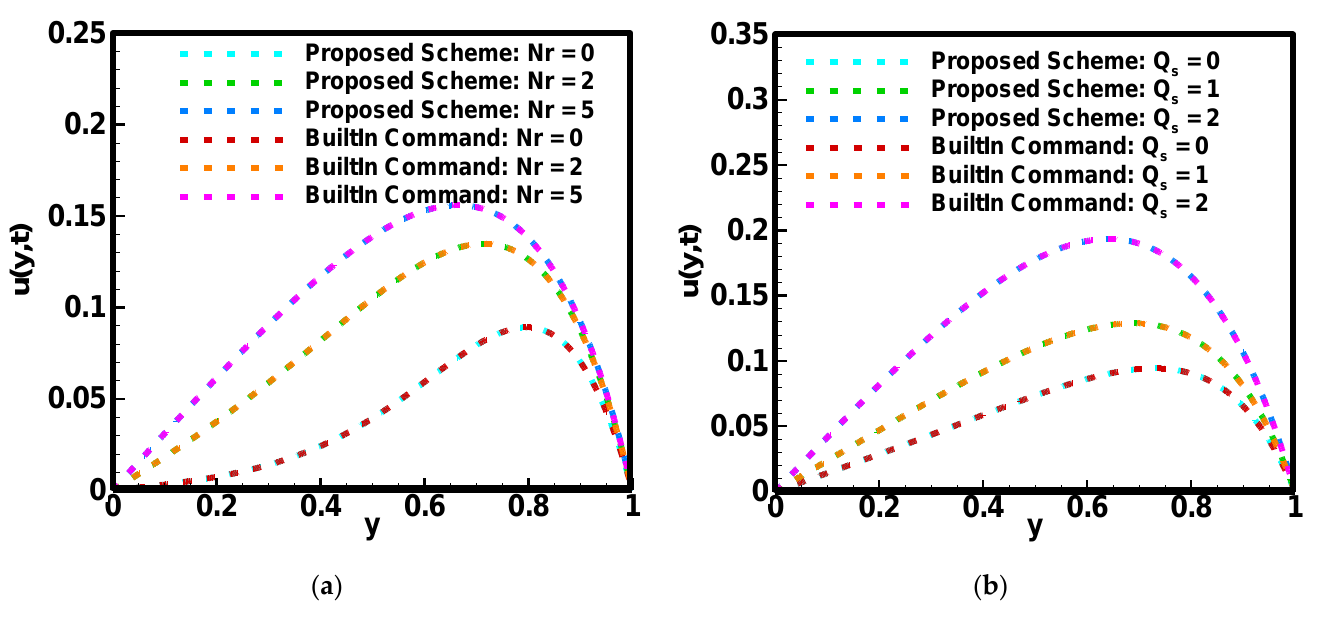
Figure 14. Comparison of dimensionless velocity between Proposed Method and Maple Built-in command against ( a ) Nr and ( b ) Q s .